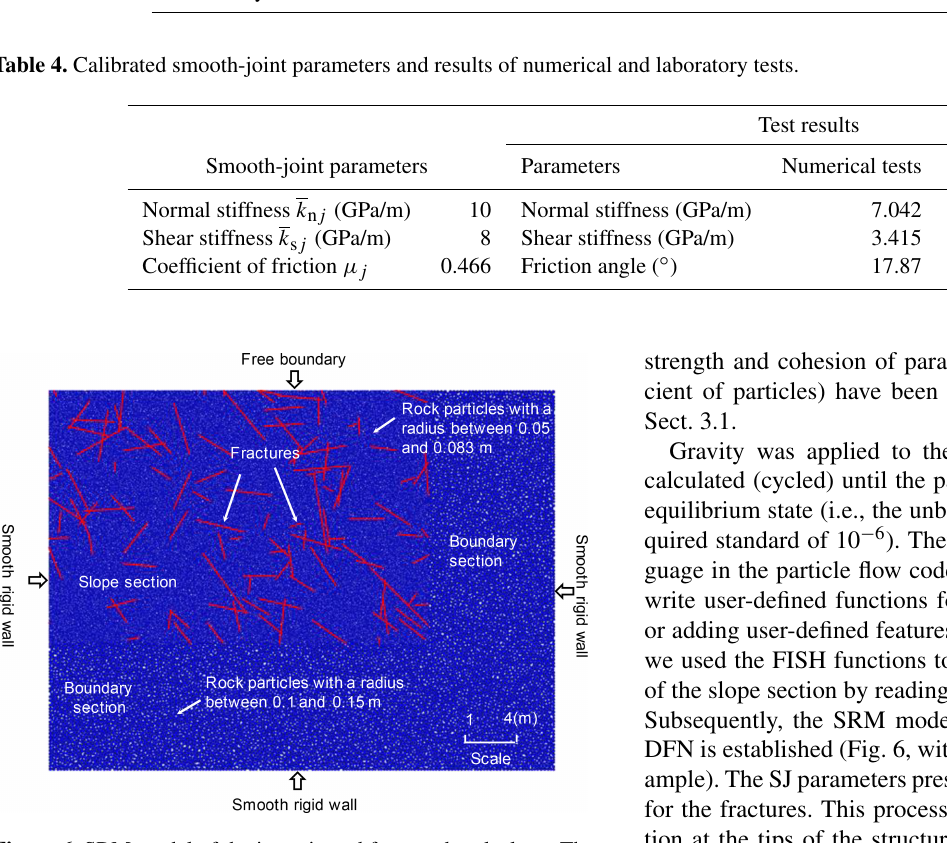
Figure 6. SRM model of the investigated fractured rock slope. The left boundary is the exposed